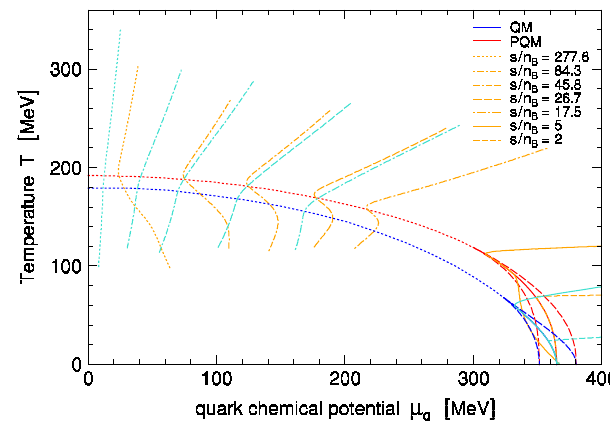
Fig. 4 The effect on the phase diagram and on the isentropic trajecto- ries of the Polyakov field. Going from the NJL to the PNJL (left panel) and from the QM to the PQM model (right panel), the CEP moves to